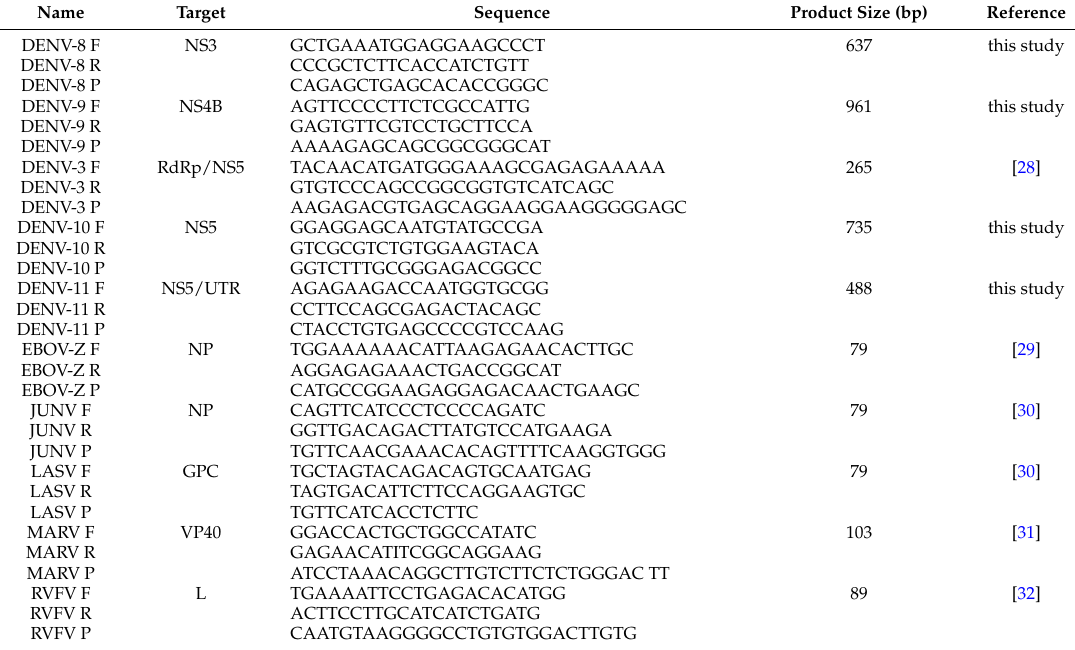
Table 2. Primers and probes used in this